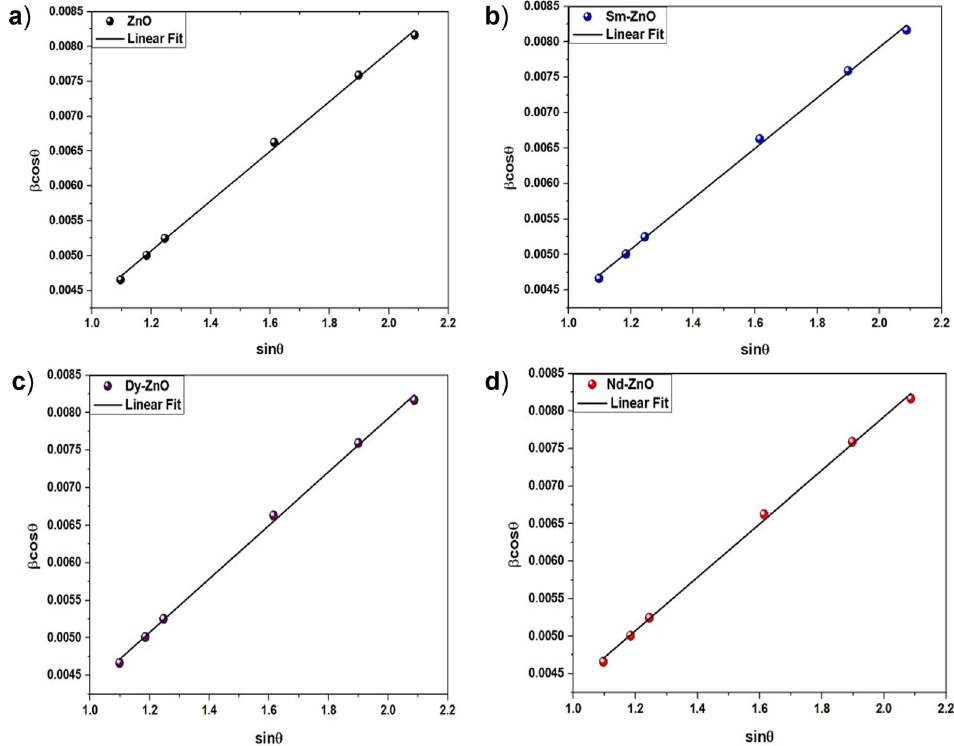
Figure 2. W-H plot for ( a ) ZnO nanoparticles, ( b ) Sm-doped ZnO nanoparticles, ( c ) Dy-doped ZnO Figure 2. W ‐ H plot for ( a ) ZnO nanoparticles, ( b ) Sm ‐ doped ZnO nanoparticles, ( c ) Dy ‐ doped ZnO nanoparticles, ( d ) Nd ‐ doped ZnO nanoparticles. nanoparticles, ( d ) Nd-doped ZnO